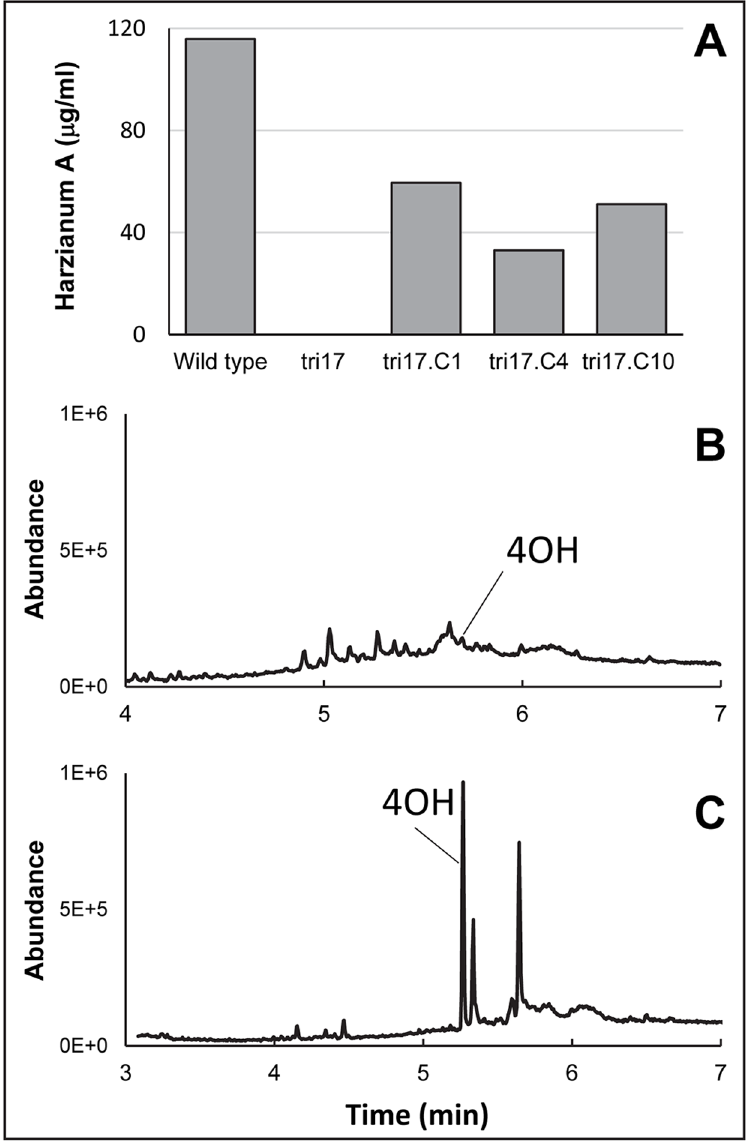
Fig 5. Functional analysis of TRI17 in Trichodermaarundinaceum . ( A ) Quantitation of harzianum A production in the wild-type strain Ta37, tri17 mutant strain tri17.139, and three tri17.139-derived strains (tri17.C1, tri17.C4 and tri17.C10) that were complemented with a wild-type copy of T . arundinaceum TRI17 .( B and C ) Total ion chromatograms of culture extracts of ( B ) wild-type progenitor strain Ta37 and ( C ) tri17 deletion mutant tri17.139. The trichothecene biosynthetic intermediate trichodermol (4-hydroxy EPT) is indicated at 5.268 min. 4OH indicates trichodermol (4-hydroxy EPT).